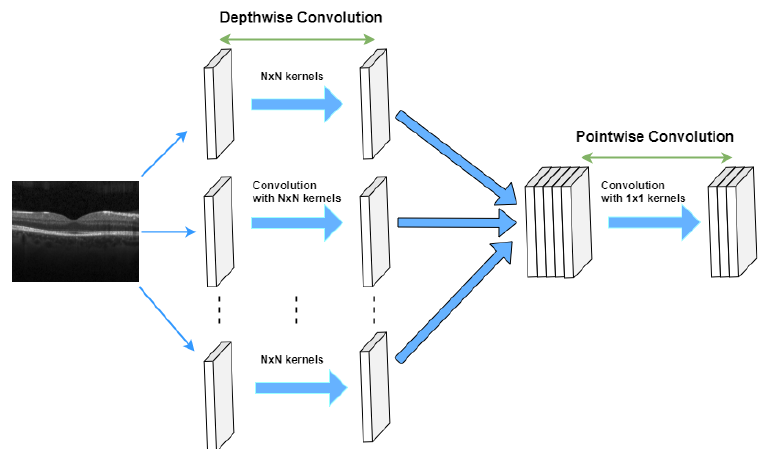
Figure 5. Depthwise separable